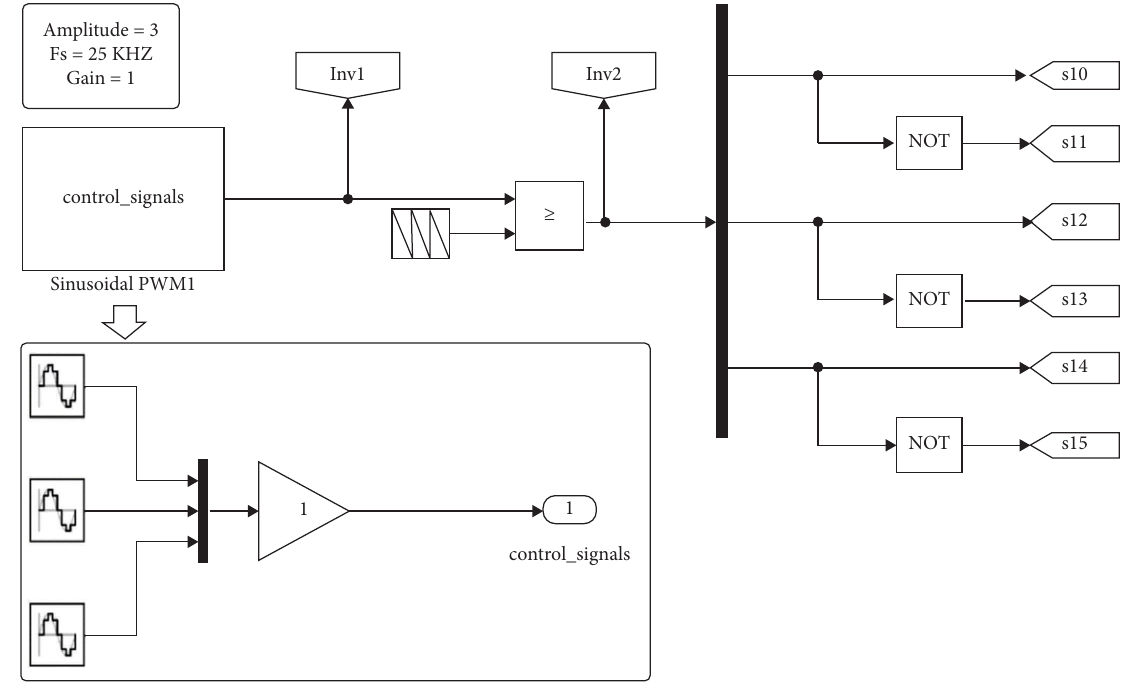
Figure 5: Switching signal generation for SMC inverter stage. Table 4: Repeating sequence data to generate triangular carrier waveform for inverter